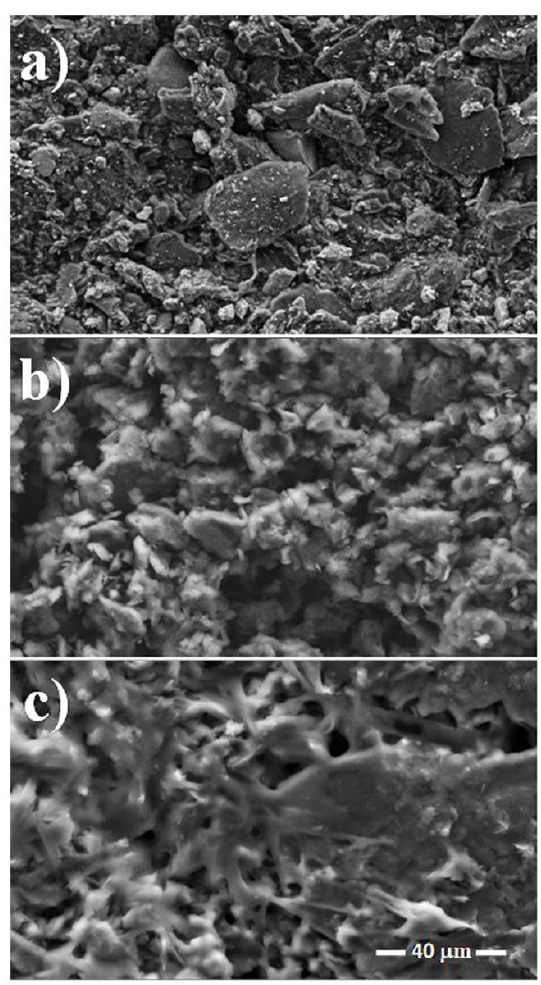
Figure 2. FESEM images for the systems ( a ) Gr, ( b ) Gr/IL and ( c ) Gr/IL/Co. Magnification = 2500×.